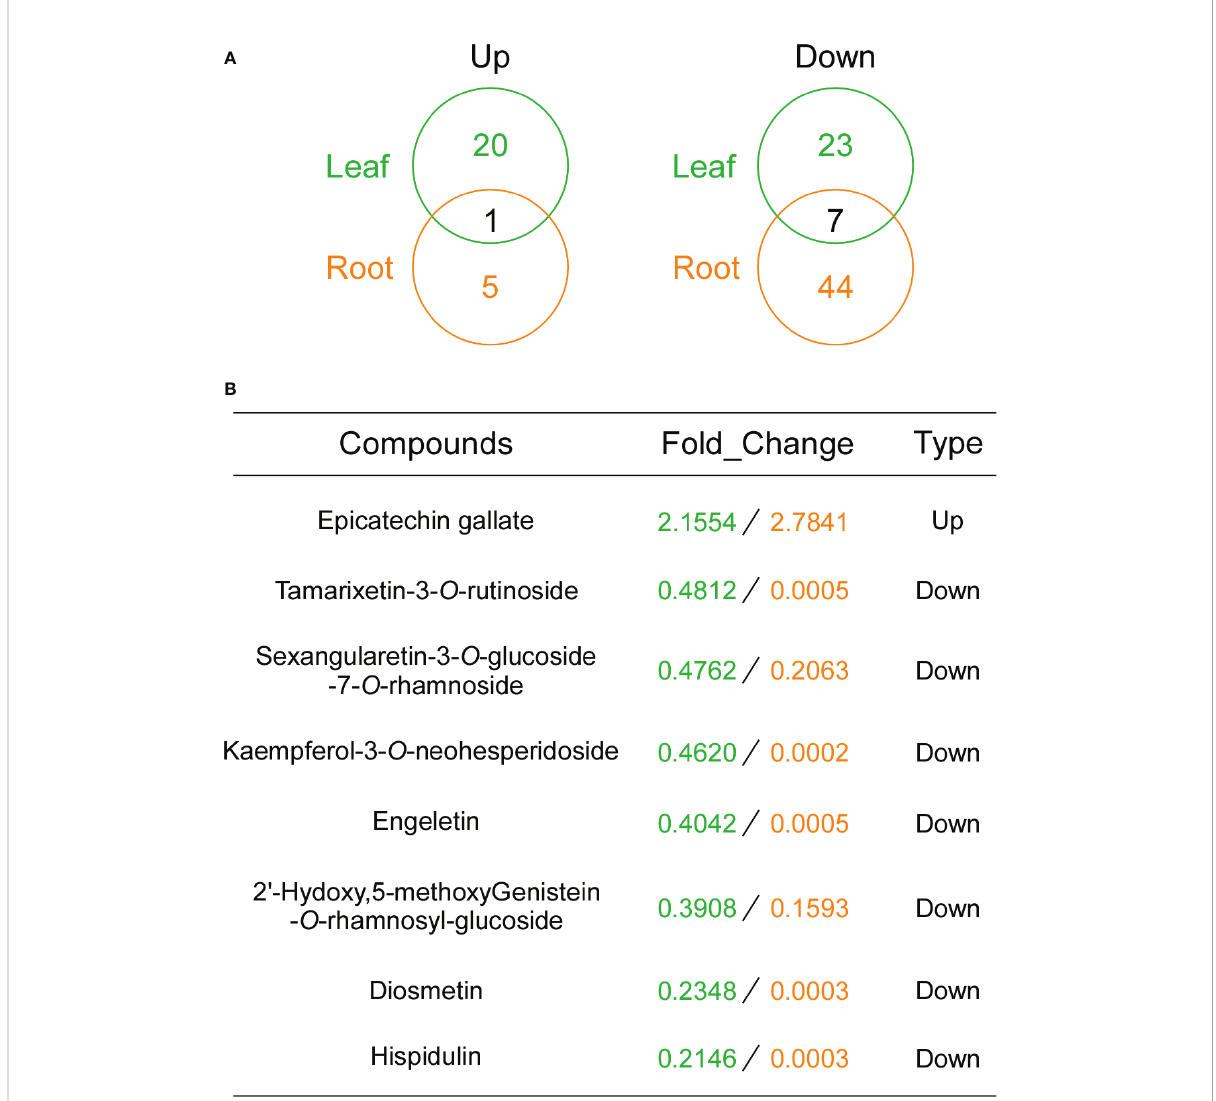
FIGURE 6 Flavonoid contents in transgenic tobacco leaves and roots. (A) Venn diagram analysis of the upregulated (left) and downregulated (right) fl avonoids in leaves and roots. The numbers of the differentially regulated fl avonoids identi fi ed in leaves and roots of transgenic tobacco plants are shown in the segments of the Venn diagram. (B) Information regarding fl avonoid compounds with the same change tendencies. Fold changes in leaves and roots are marked in green and yellow,